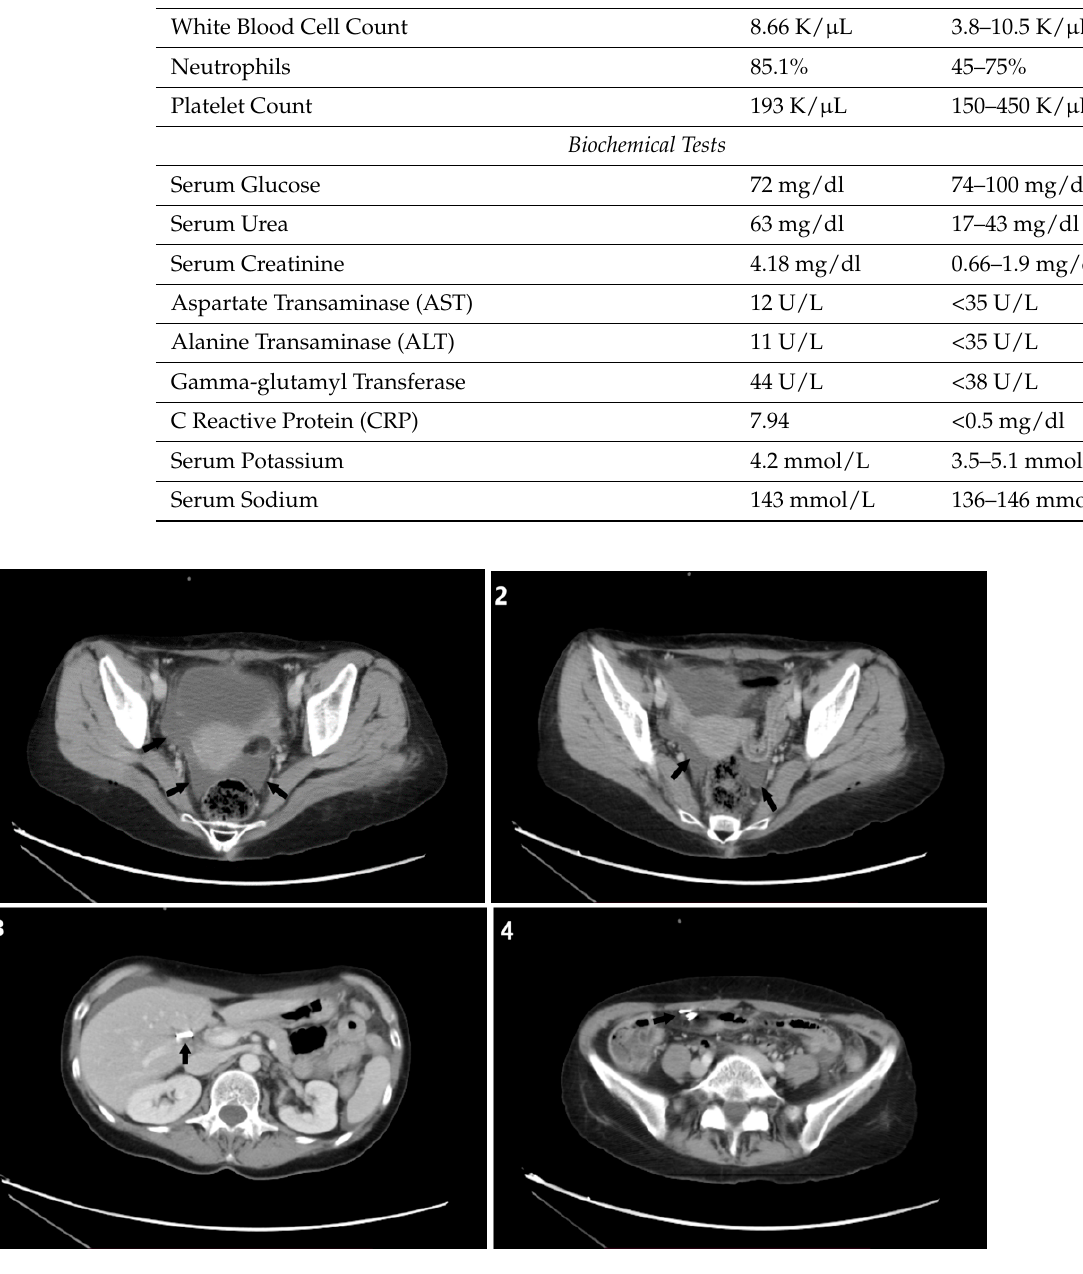
Figure 1. CT abdomen; ( 1 , 2 ) Free intraperitoneal fluid with similar density to urine in the bladder (black arrows) ( 3 ) Surgical clips in the anatomic position of the gall bladder (black arrow). ( 4 ) Surgical clips in an ectopic position near the ileocecal valve (black arrow).